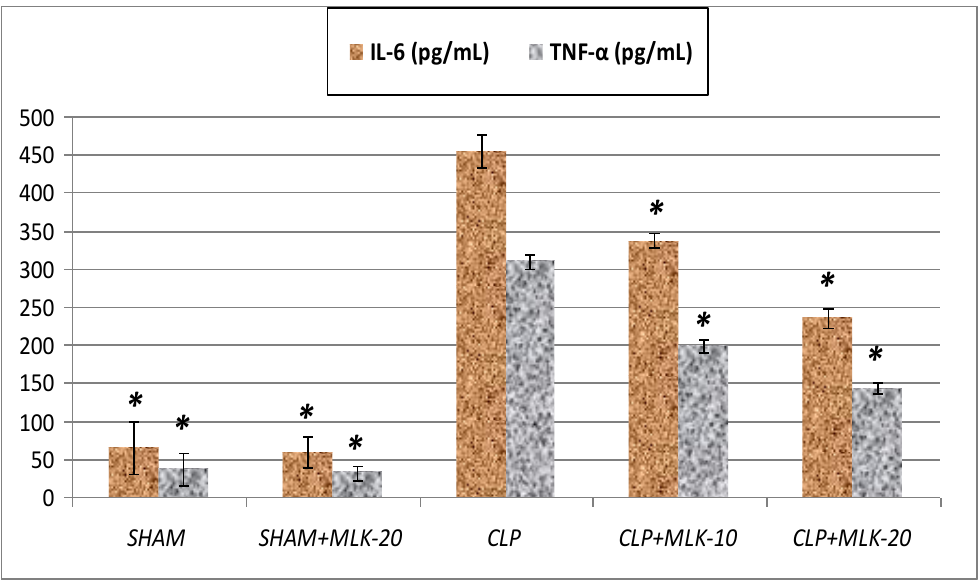
FIGURE 2. The effects of MLK on serum IL-6 and TNF-α levels in CLP-induced septic rats. CLP: cecal ligation and puncture applied; MLK: montelukast treated; SHAM: sham operated. * Means significantly different at p < 0.05 when compared to CLP control group.